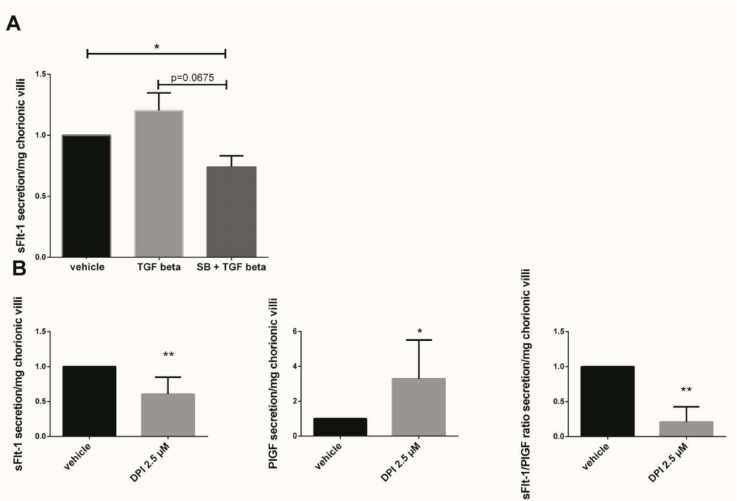
Figure 5. Effects of TGF- β 1, p38 inhibitor (SB203580) and DPI on the sFlt-1 secretion by chorionic villi. ( A ) Chorionic villi were treated with TGF- β 1 (10 ng/mL) for 48 h or pre-incubated with SB203580 (10 µ M) for 1 h prior to the TGF- β 1 treatment. The secretion of sFlt-1 was expressed as a change rate as compared with the vehicle group. Data are represented as mean ± SEM. Paired t-test were applied, n = 7 different placentas; ( B ) sFlt-1, PlGF secretion and sFlt-1/PlGF ratio in first trimester chorionic villi supernatant treated with 2.5 µ M Nox inhibitor DPI. For sFLt-1, and PlGF secretion, data are represented as mean +/ − SD, * p < 0.05, ** p < 0.01, n = 8 different placentas. Paired t-test was applied. For the sFlt-1/PlGF ratio, data are represented as mean +/ − interquartile range. ** p < 0.01, n = 8 different placentas. Wilcoxon test was applied. Vehicle refers to DMSO